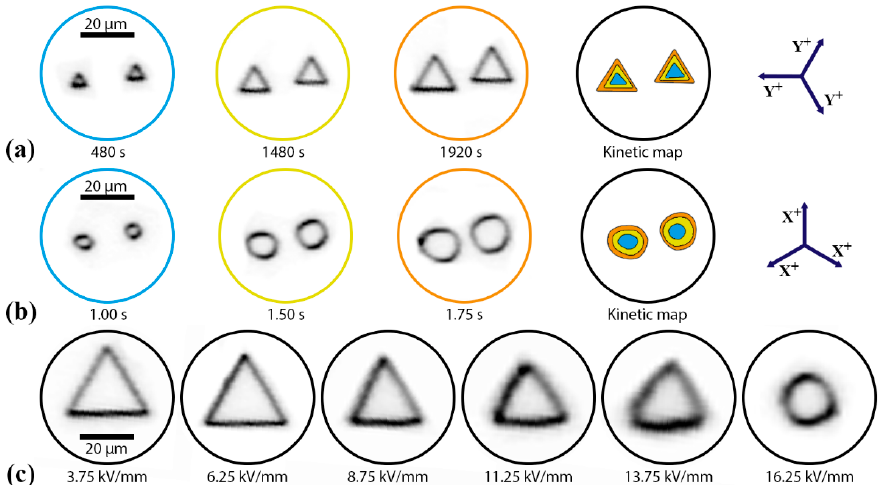
Figure 4. The domain wall images and kinetic maps for the growth of an isolated domain for E ex kV / mm: ( a ) 3.75 and ( b ) 16.25. ( c ) Field dependence of the shape of the isolated domain.